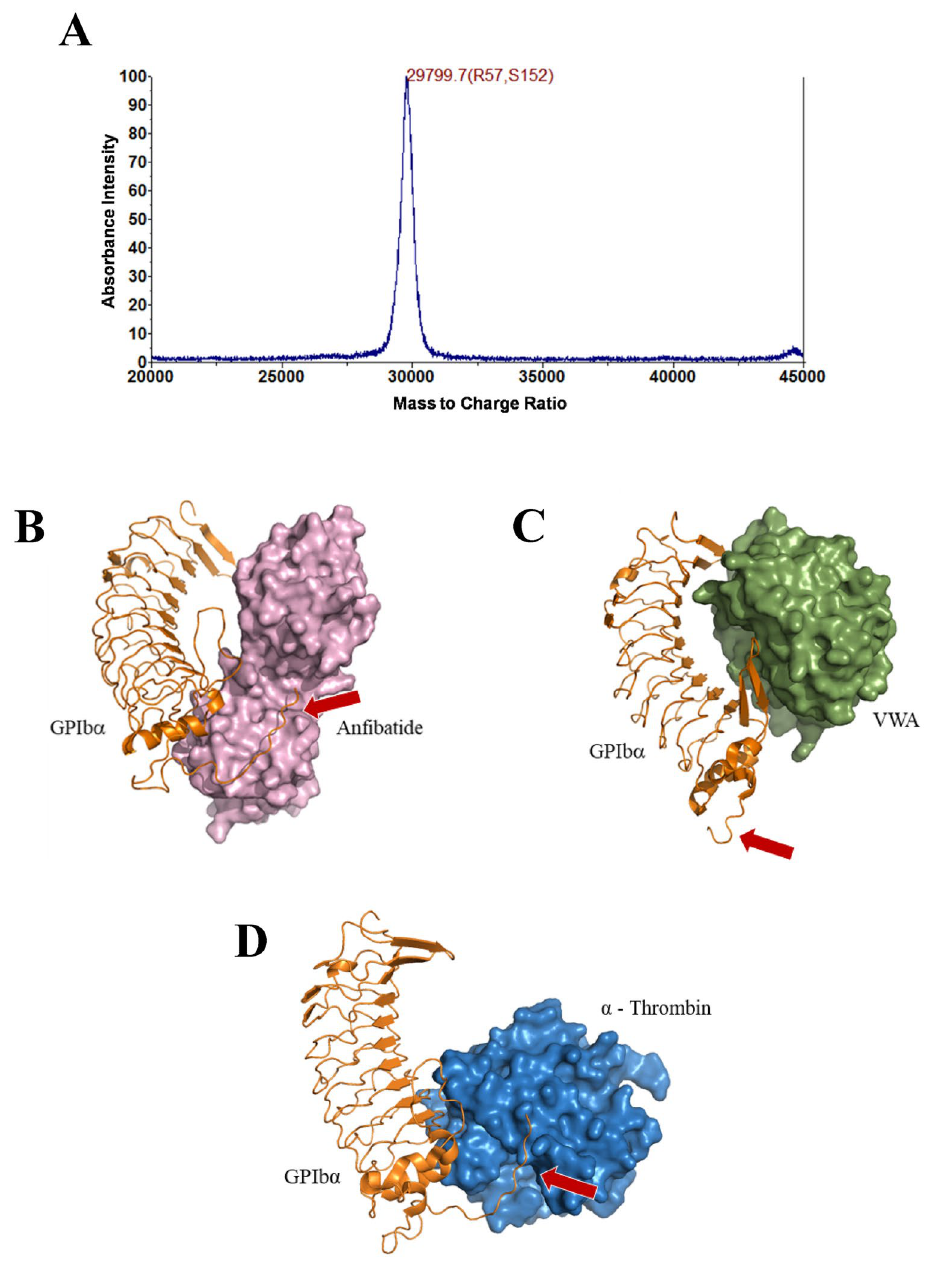
Figure 1. Purification and structure of anfibatide with GPIbα. ( A ) MALDI-TOF mass spectrometry showed a mass to charge ratio (m/z) of 29,799.7. Three-dimensional models of ( B ) structure of anfibatide (purple) integrated with GPIb (orange) and ( C ) VWF-A1 domain (green) and GPIbα complex from PDB entry 1SQ0